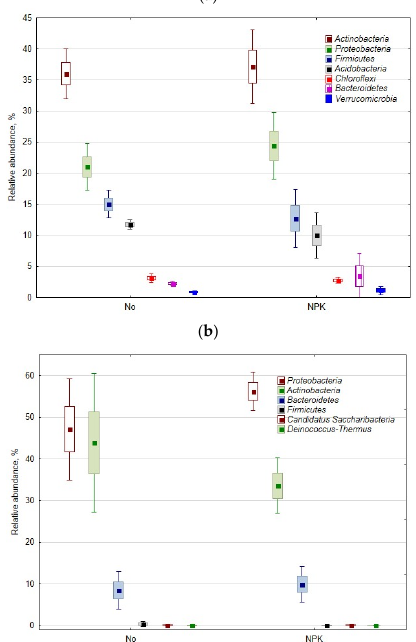
Figure 1. The relative abundance of bacterial phyla in the rhizosphere (only dominants ( a )) and roots (all phyla ( b )) of tomato plants grown under different fertilization on Phaeozem in the open field in the south of West Siberia. Squares denote means, boxes denote standard errors, and whiskers denote standard deviations. A taxon was considered dominant if its relative abundance was ≥ 1.0%.